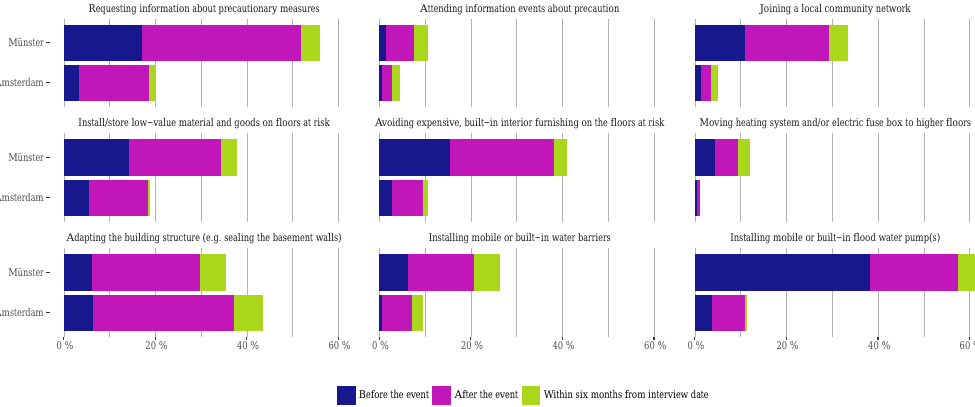
Figure 7. Percentage of respondents undertaking precautionary measures: before the event (blue), after the event (purple) or planned to be implemented within 6 months from interview date (green). Only precautionary measures that were asked in both cities are shown.